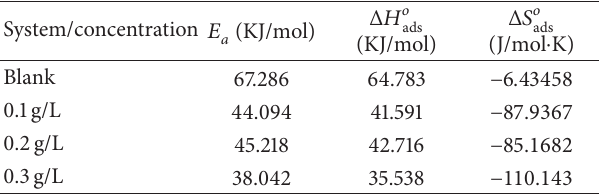
Table 4: The activation energy (KJ/mol), enthalpy (KJ/mol), and entropy (J/mol ⋅ K) of mild steel corrosion in 1MHCl with GA inhibitor.